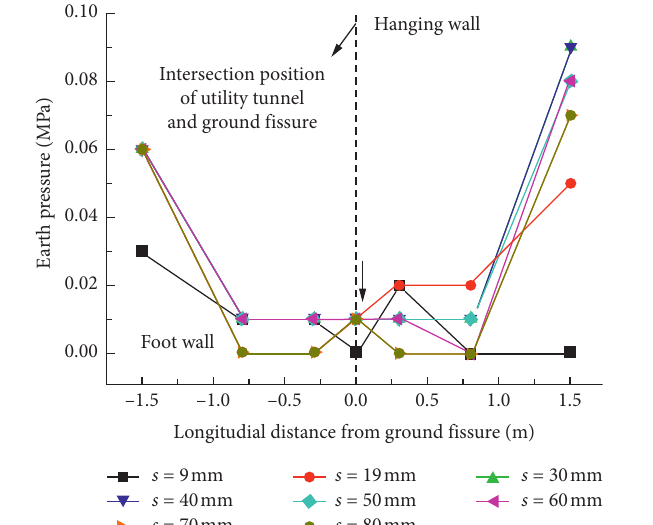
Figure 5: Variation of top contact pressures of the utility tunnel crossing the ground fissure section ( H � 4.5m).